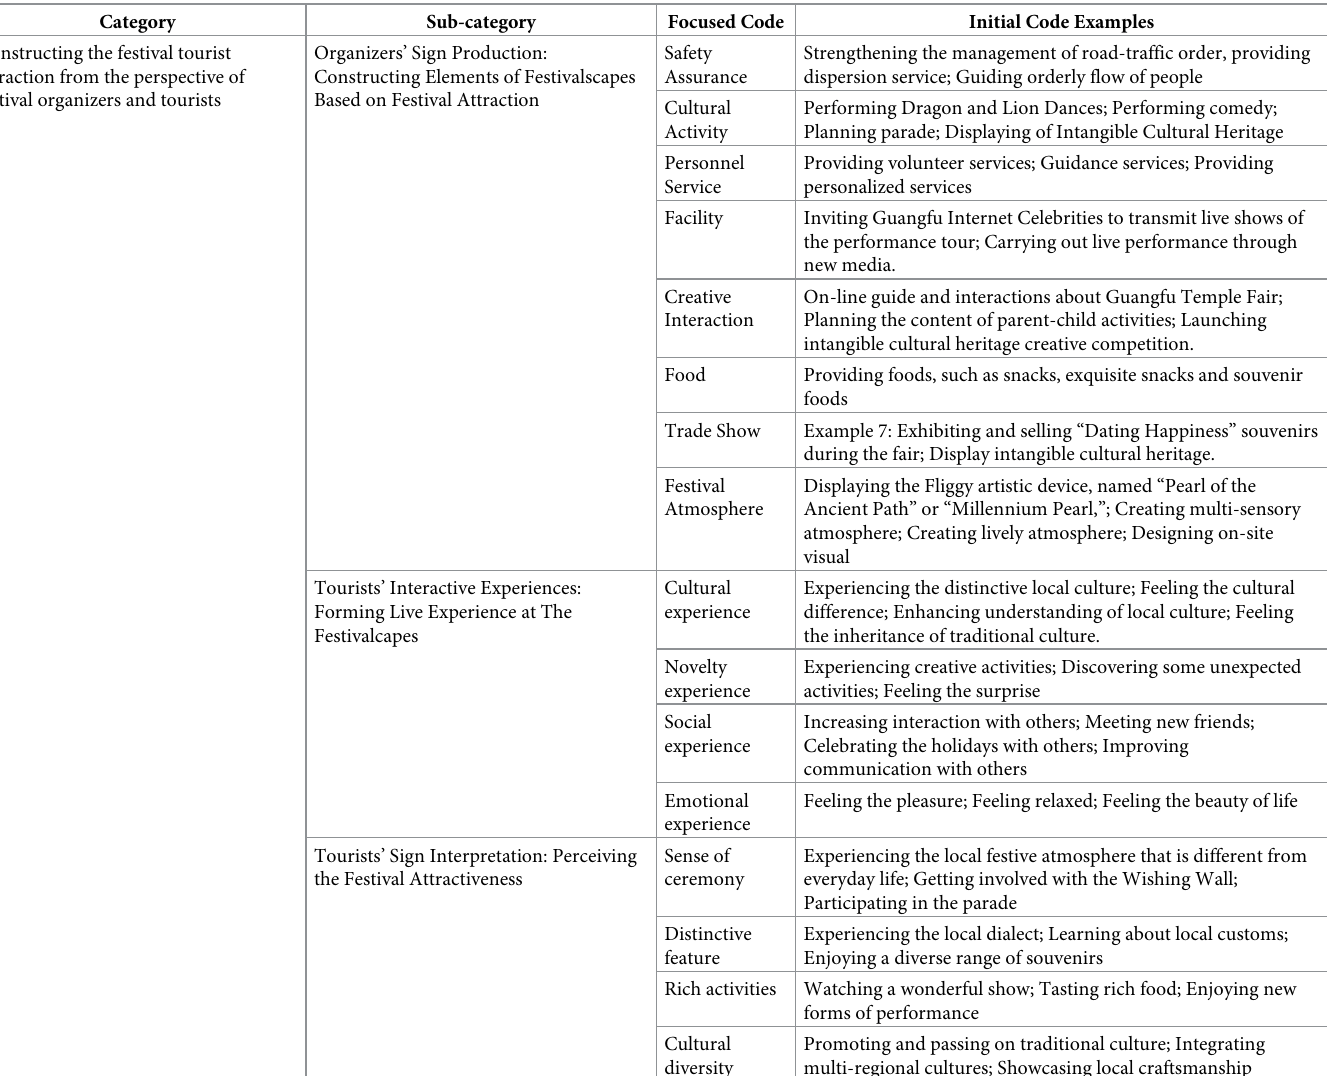
Table 2. Categorization of